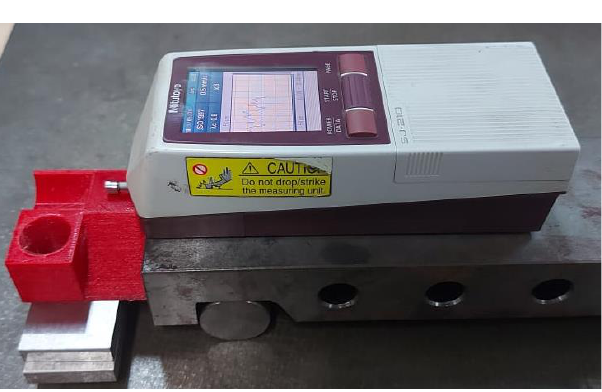
Figure 3. Surface roughness measurement using SURFTEST SJ-210.